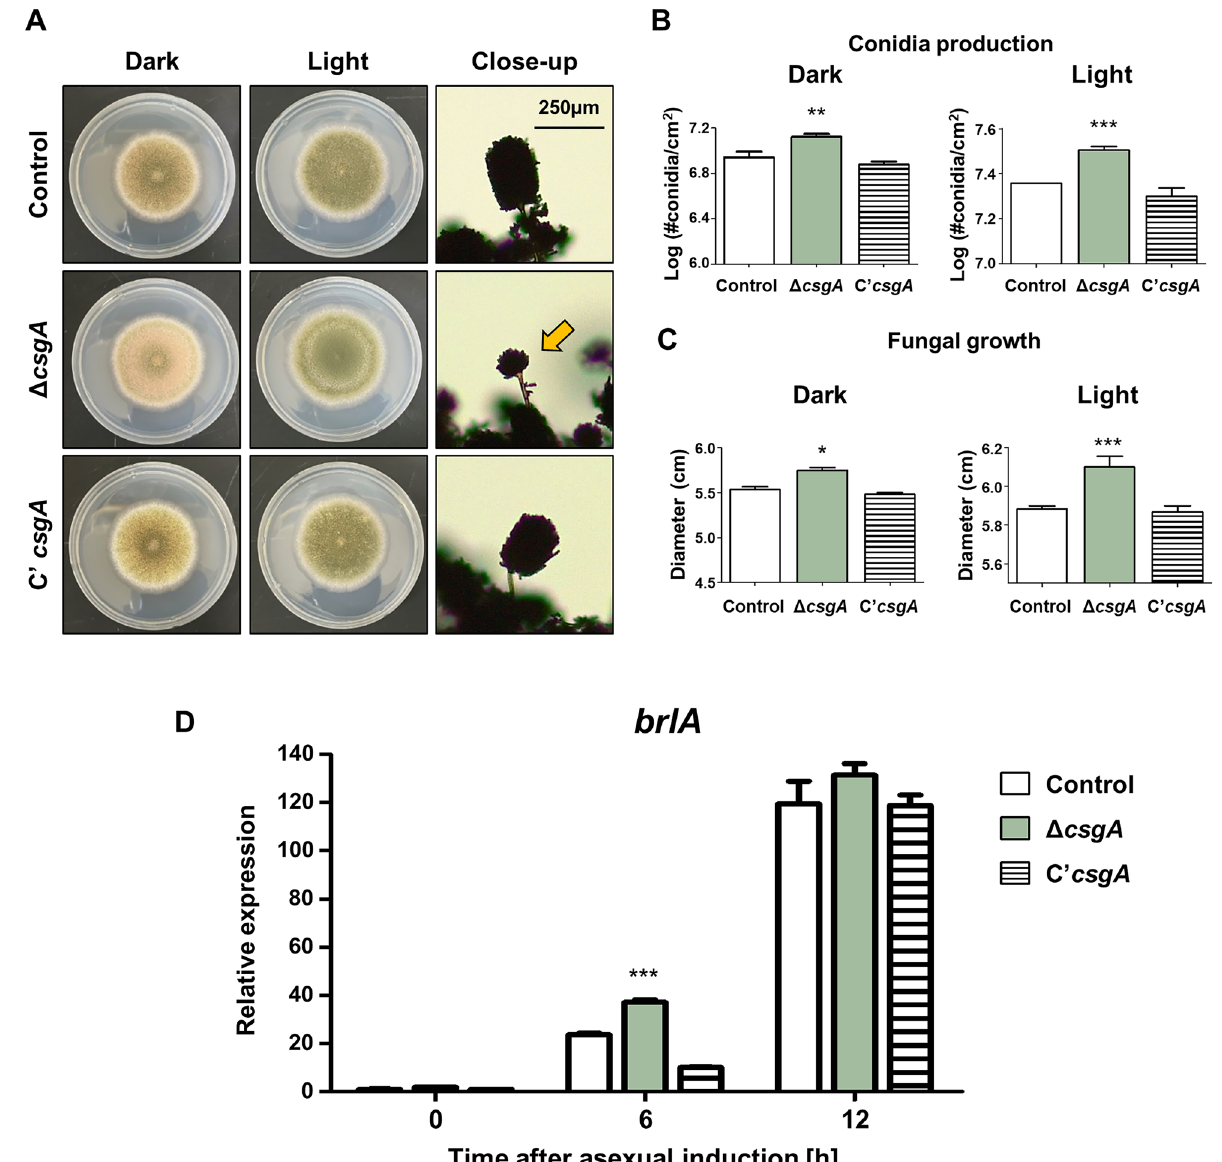
Figure 2. The roles of csgA in asexual development. ( A ) Colony photographs of control (TNJ36), Δ csgA (THJ13.1), and C’ csgA (THJ28.1) strains point-inoculated on solid MMG, grown for 5 days at 37 °C in dark and light conditions. Close-ups show conidiophores of each strain. ( B ) Quantitative analyses of conidia production by each strain shown in ( A ). ( C ) Quantitative analyses of fungal growth of each strain. * p < 0.05, ** p < 0.01, *** p < 0.001. ( D ) The mRNA expression of brlA in conidia. qRT-PCR analyses of the mRNA expression levels of brlA in each strain after asexual induction. (*** p <